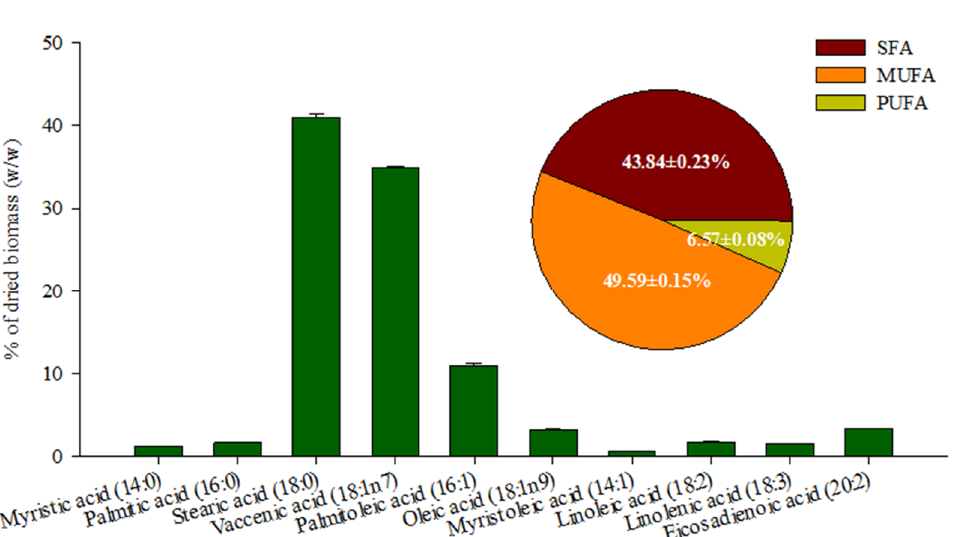
Figure 7. Contents of saturated fatty acids (SFA), monounsaturated fatty acids (MUFA), polyunsaturated fatty acids (PUFA) and fatty acid profiles of lipid extracted from Coelastrella sp. KKU-P1 biomass.